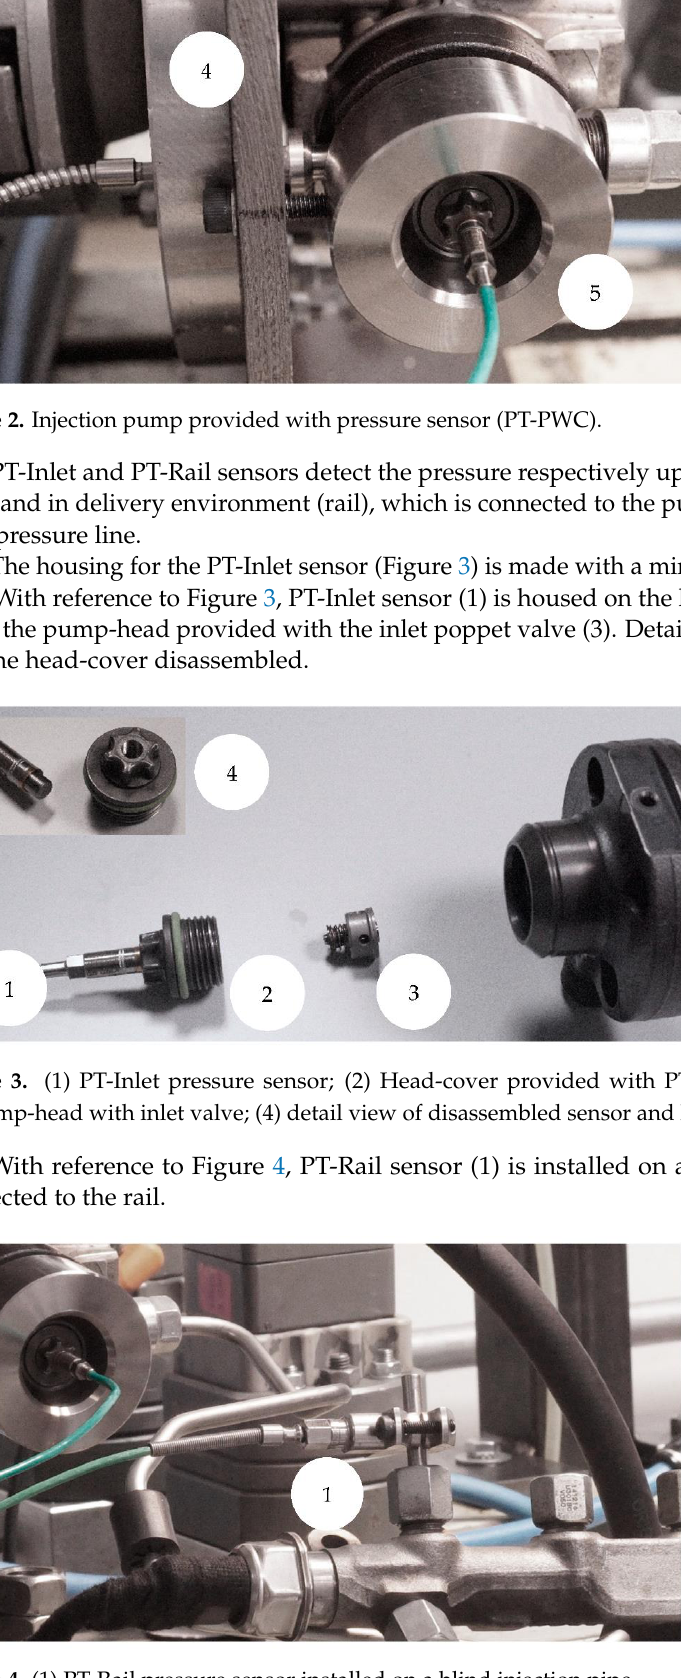
Figure 4. (1) PT-Rail pressure sensor installed on a blind injection pipe. A rotary encoder detects the angular position of the pump shaft. Once the cam profile and its phasing are known, the position of the pumping element and the volume of fluid inside the working chamber are calculated. The instrumentation signals are sent to a multi-channel DAQ system and simultaneously acquired. Table 2 reports the features of the instrumentation used. Table 2. Instrumentation features. Pressure Measurement Denomination